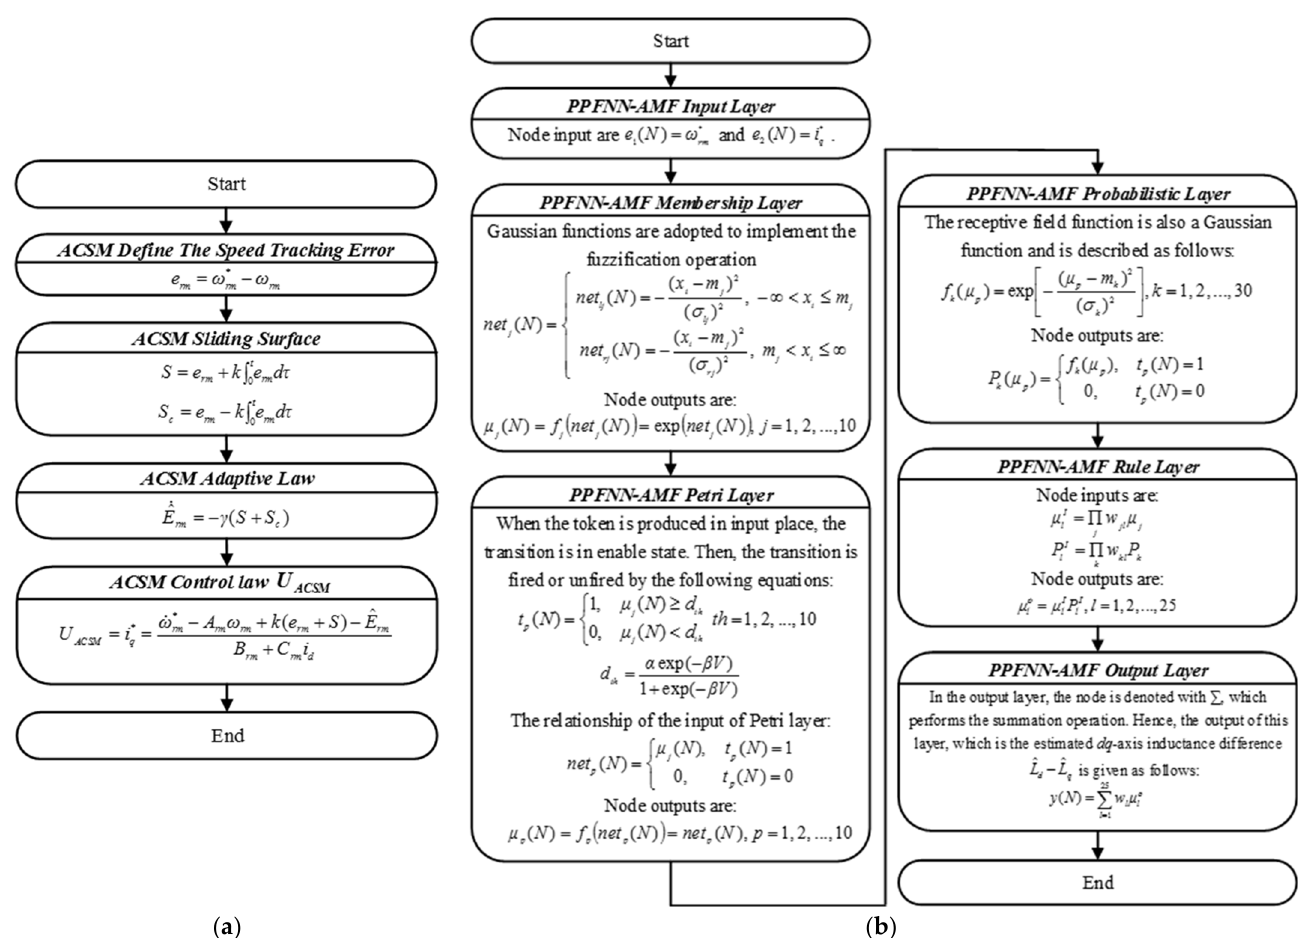
Figure 4. Flowcharts of the proposed controllers in DSP: ( a ) ACSM speed controller; ( b ) PPFNN-AMF.